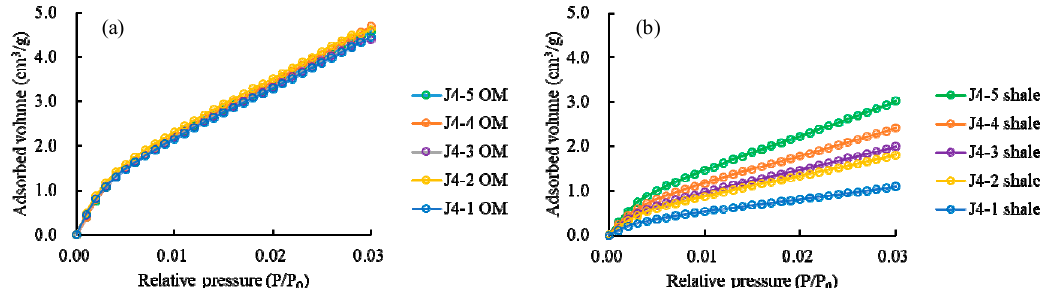
Figure 2. Comparison of low-pressure CO 2 adsorption isotherms of ( a ) isolated OM samples and ( b ) bulk shale samples.